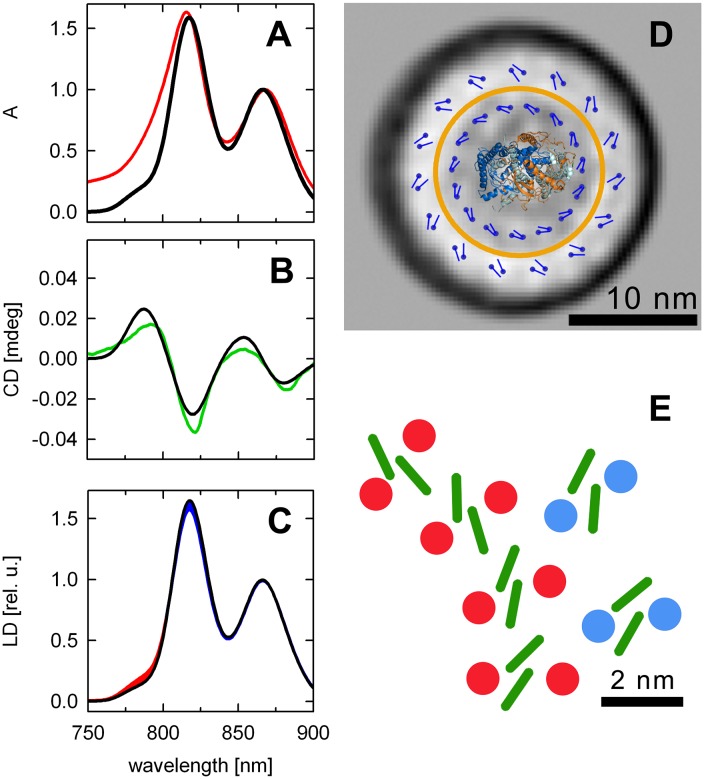
Model of G. phototrophica light-harvesting complex. Panels on the left show (A) absorption, (B) CD, and (C) LD spectra. The recorded NIR spectra (in color) are compared with the simulated steady-state spectra (in black). Blue area in (C) depicts the spectral region having LD > absorbance, red area marks the region with LD < absorbance (after normalization to B868 maximum). (D) Arrangement of BChl molecules in the complex used to calculate the steady-state spectra in (A-C). Yellow ring indicates the size of the LH1 complex from R. rubrum for comparison. (E) Detail of the section of the complex showing the hypothetical position of protein helices (red and blue dots) and BChl a molecules in green. These are taken directly from the structure of light-harvesting complexes. BChl, bacteriochlorophyll; CD, circular dichroism; LD, linear dichroism; LH1, light-harvesting complex 1; mdeg, millidegree; NIR, near infrared region; rel. u., relative units.